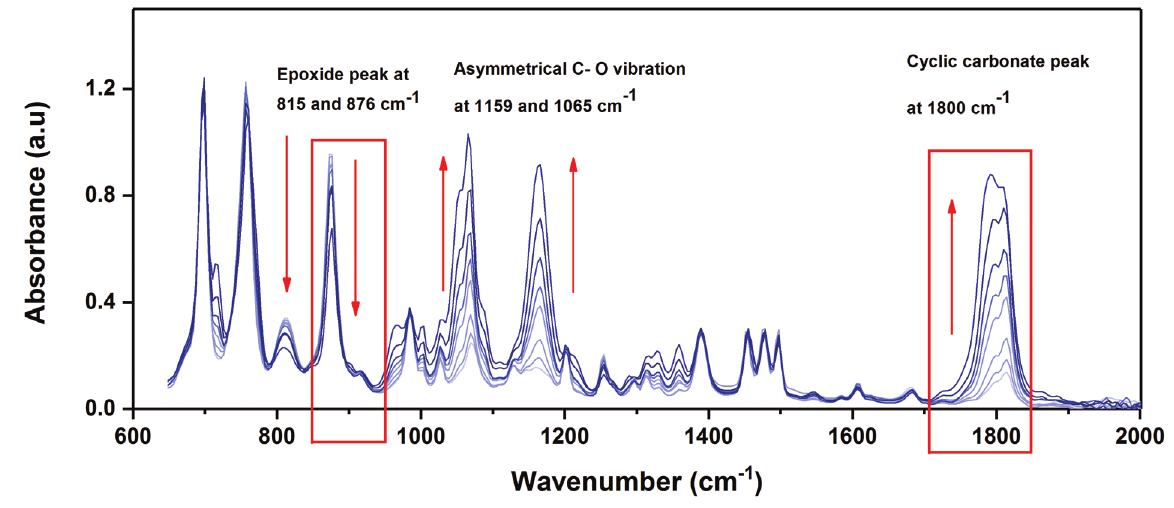
Figure 4: FTIR spectroscopic-monitoring of styrene carbonate (SC)